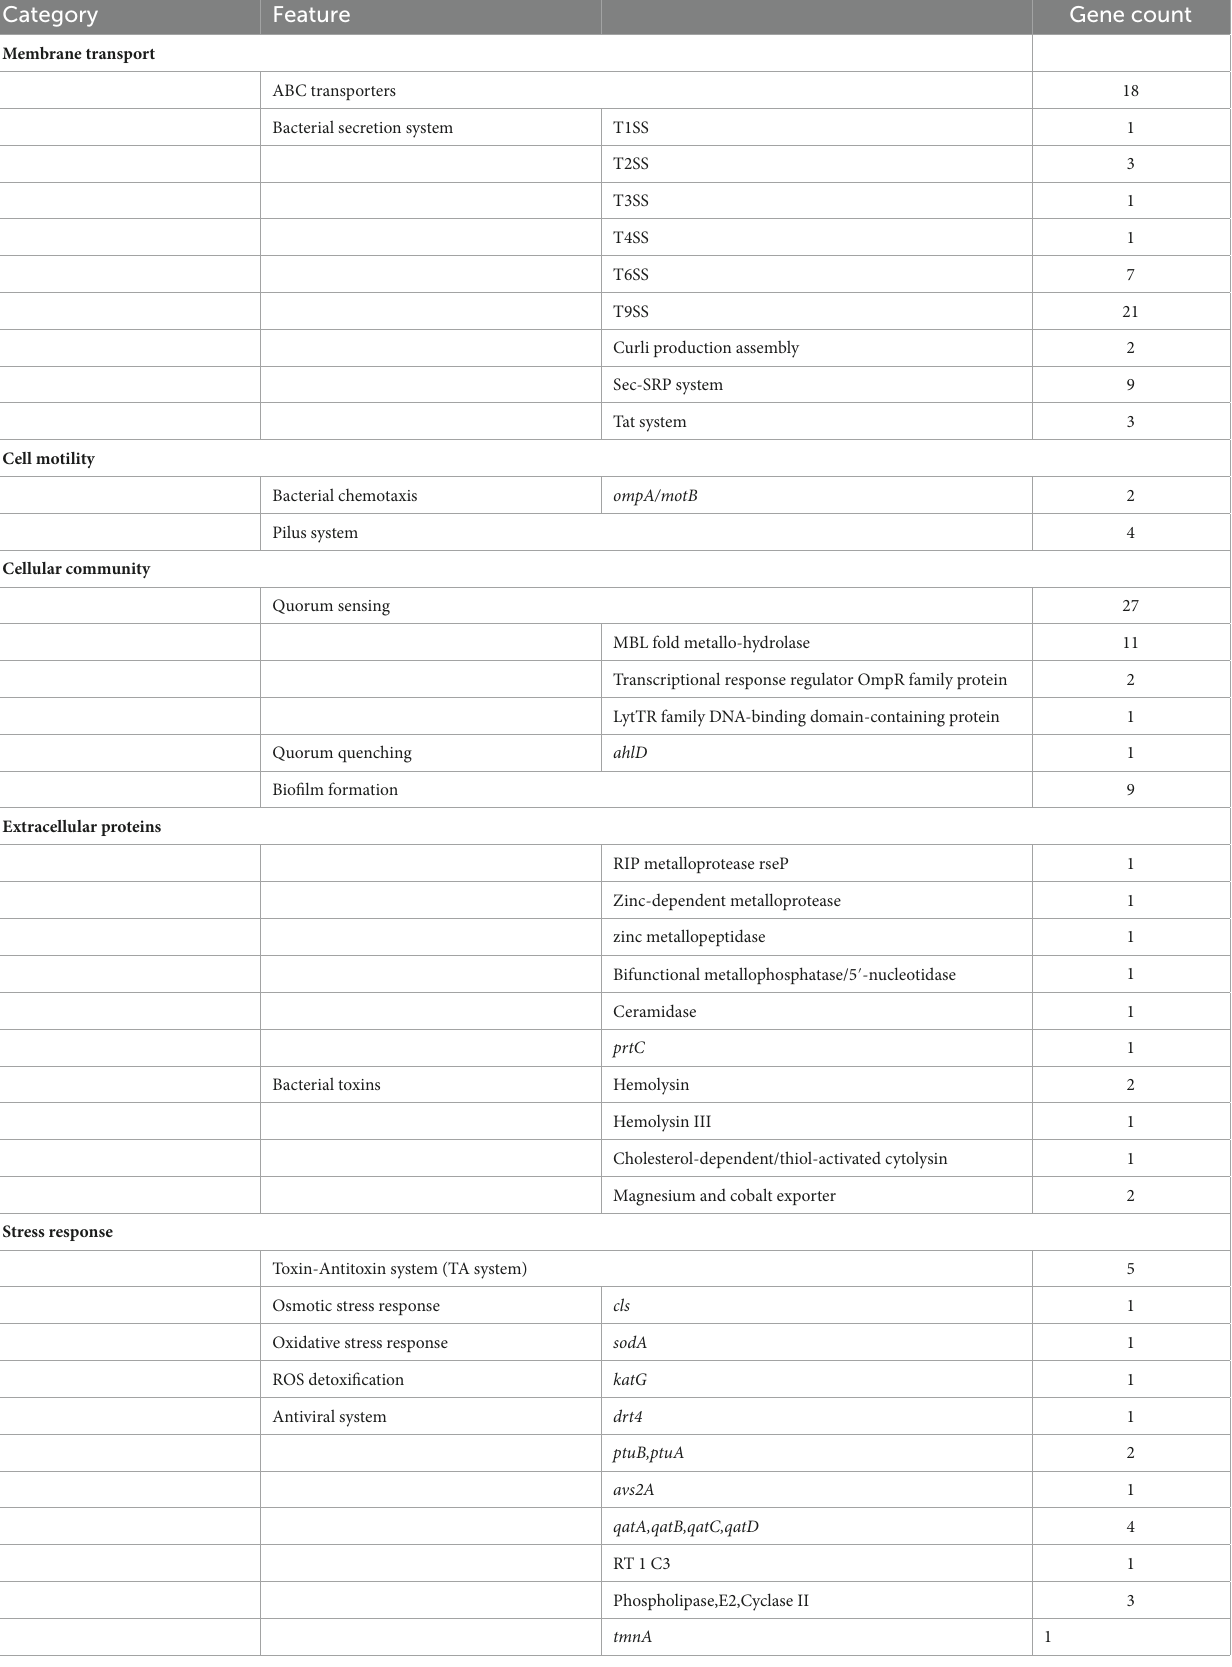
TABLE 4 Genes related to putative virulence factors, stress response and metabolism elements present in the LAR25 genome.